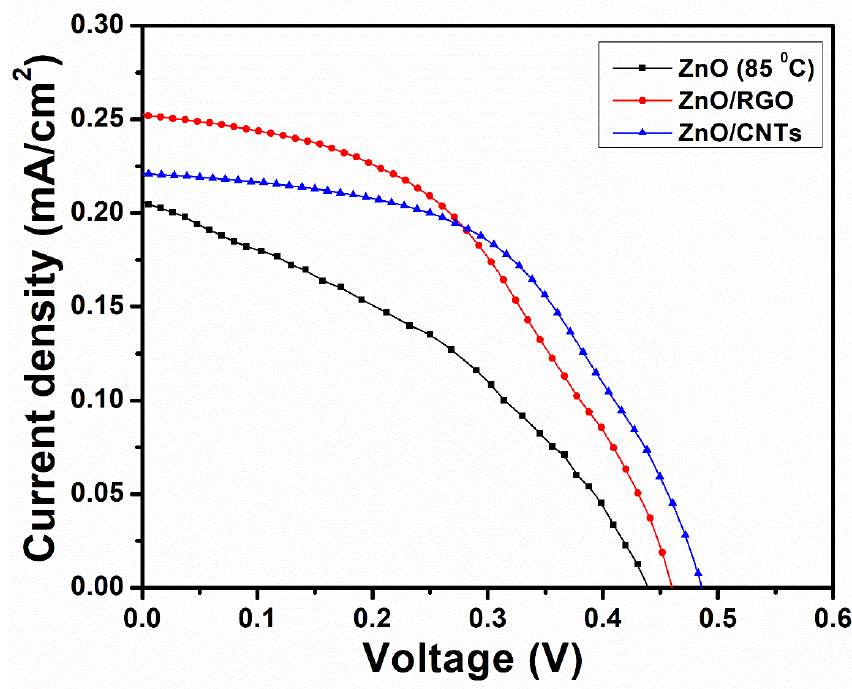
Figure 8. Current density–voltage (J–V) curves of ZnO nanocomposites. Table 1. Summarized table of DSSCs parameters for samples of ZnO and their nanocomposites. Samples